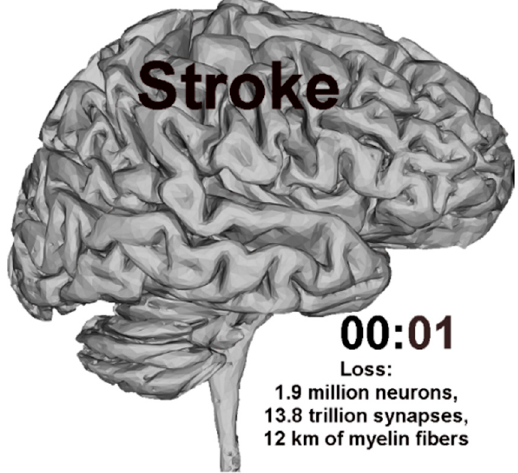
Figure 1. Average number of lost cells during one minute of stroke.